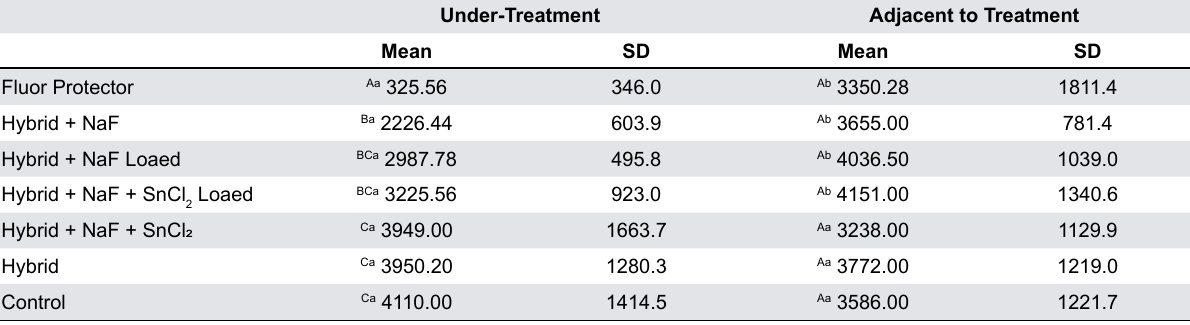
Under-Treatment Adjacent to